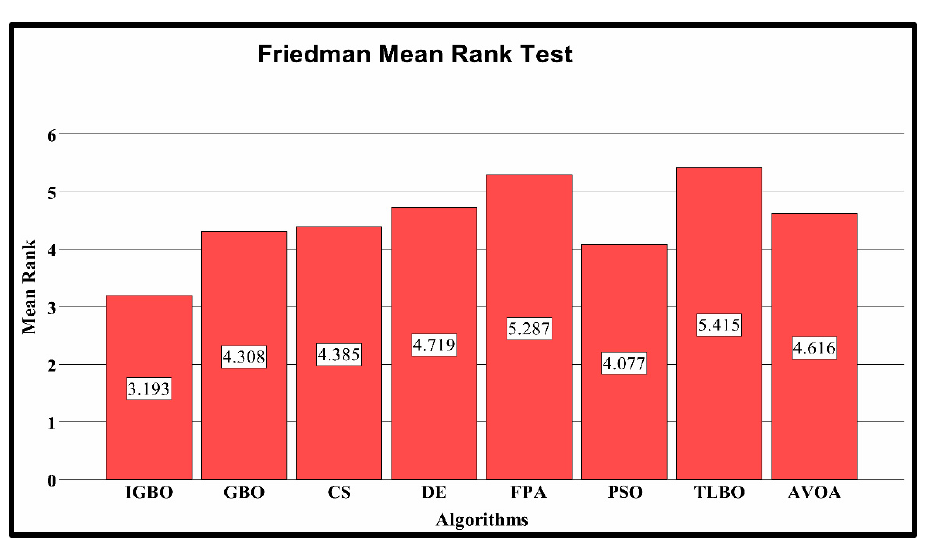
Figure 8. Convergence curve of the functions. 7.2. Comparison of Computational Time The modifications to improve original GBO, make it able to find optimal from the entire feasible range with the proper balance of global and local search capabilities More- over, they effect to boost the convergence speed of IGBO compared to its counterparts. Each algorithm runs 1000 iterations and the average of the elapsed time is considered a